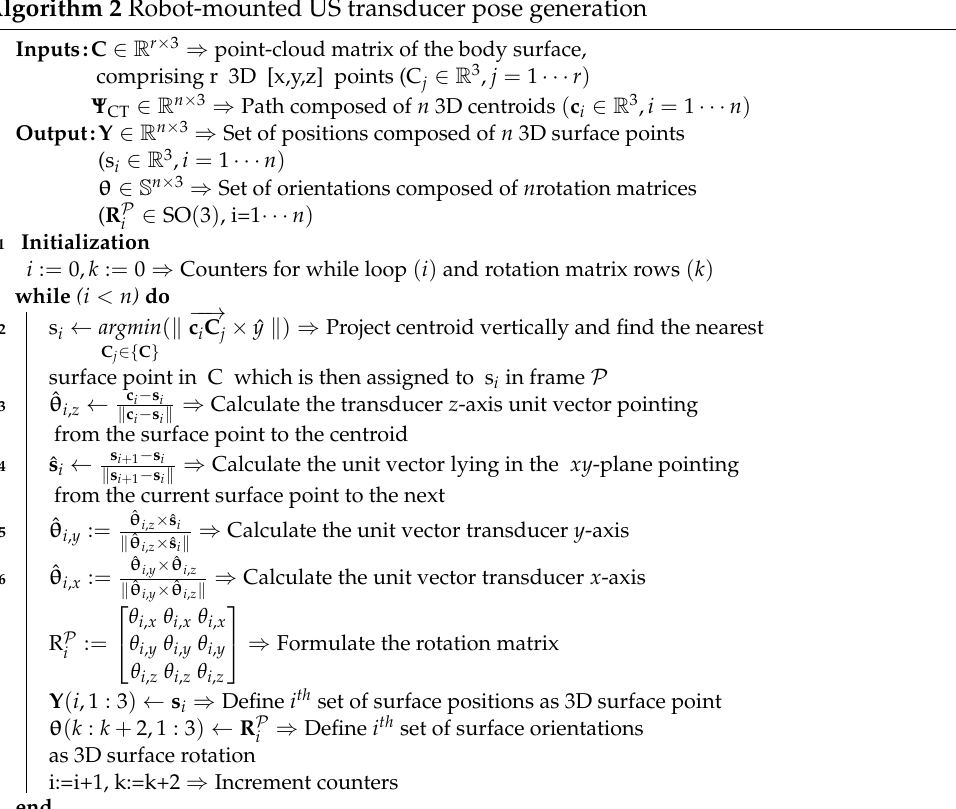
Algorithm 2 Robot-mounted US transducer pose generation Algorithm 2: Robot-mounted US transducer pose